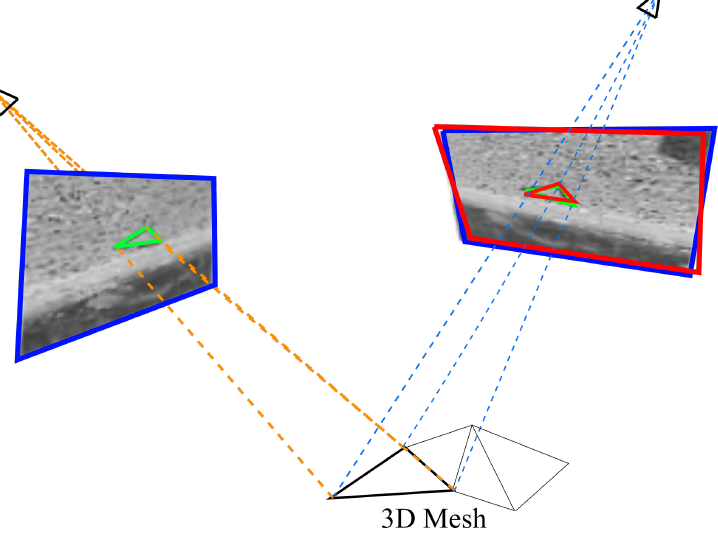
Figure 16. Minor error in image orientation may cause errors in ROI normalization. ( Left ): master image, ( Right ): the blue frame is an image orientation with a minor parallax error, the red one is a corrected orientation. If we normalize the geometry of the ROI in the right image (green triangle region) with respect to the left image by an affine transformation estimated from triangle vertices, they are not exactly in the same